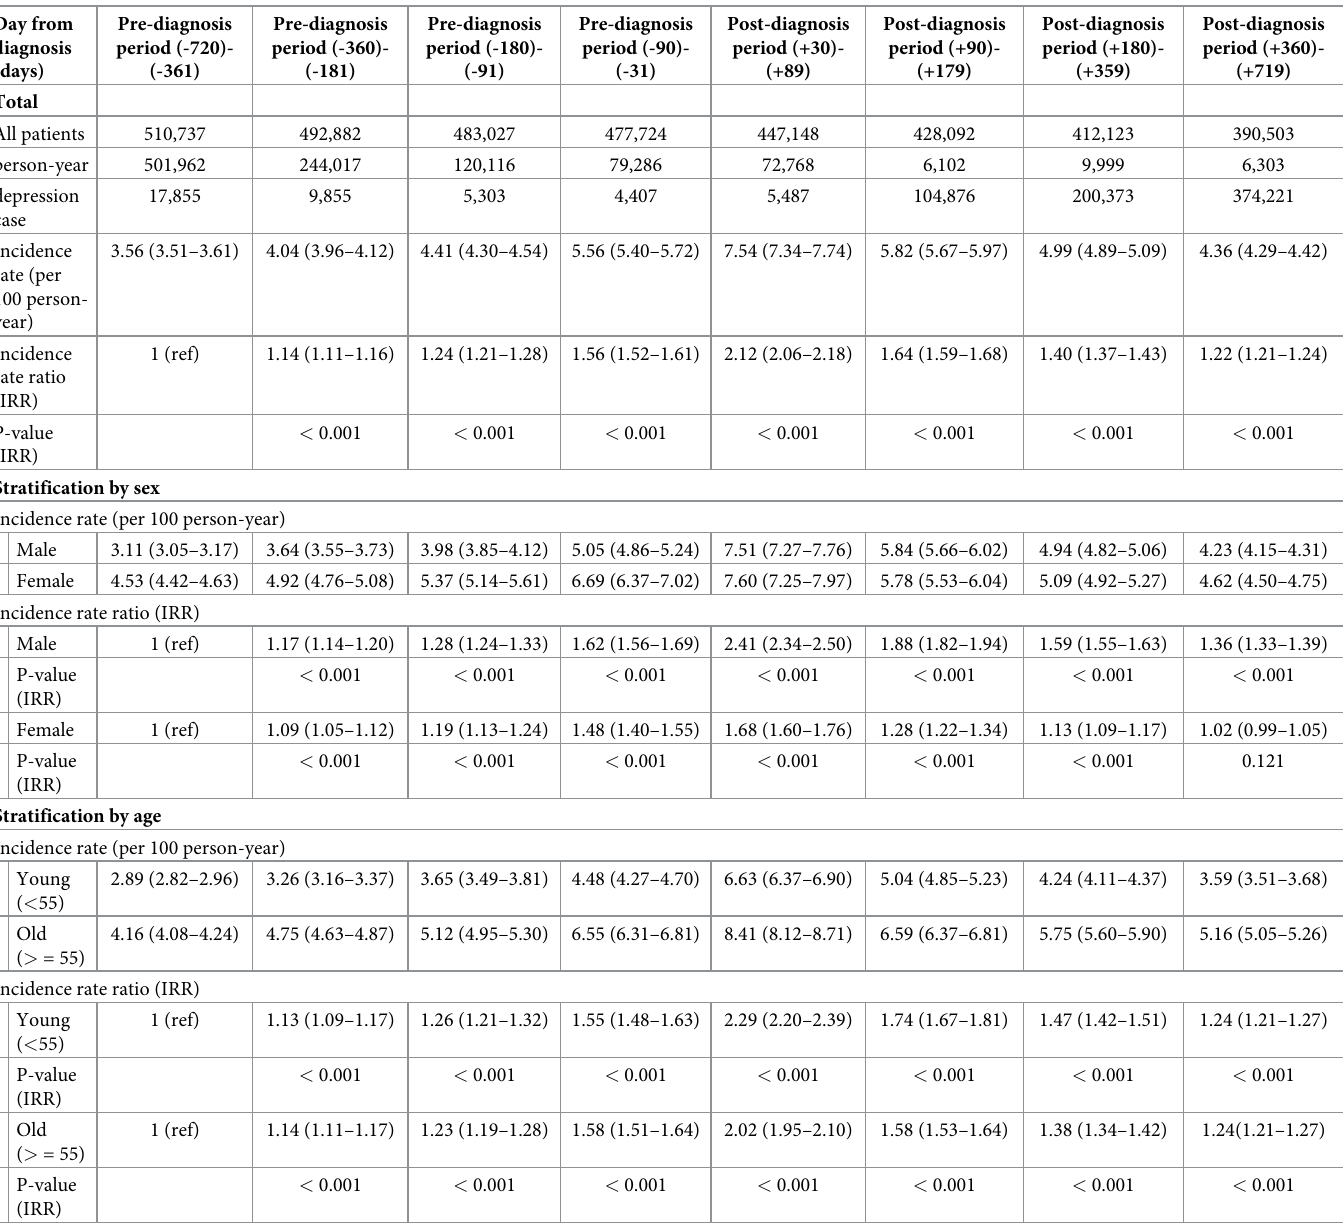
Table 1. Incidence of depression in patients with